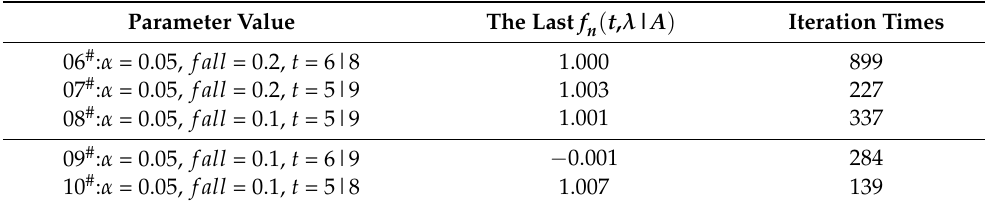
Table 3. The number of iterations required for the convergence of the model when the data update time fluctuates around the set period ( 𝑇 = 7 ).